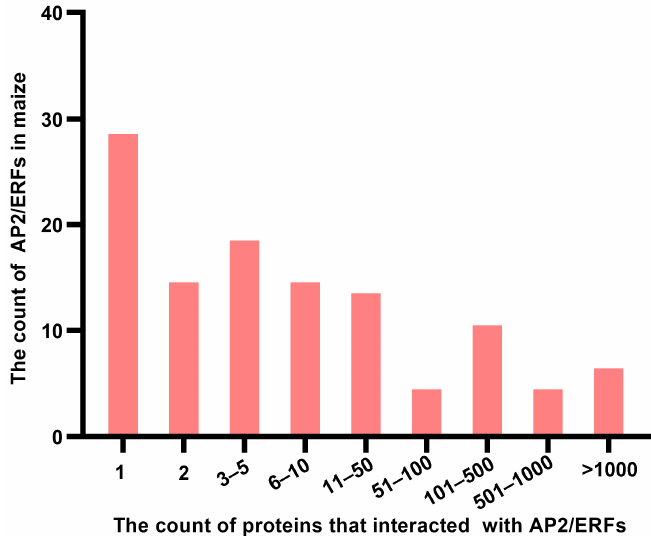
Figure 3. The number of AP2/ERFs and their partners in maize.